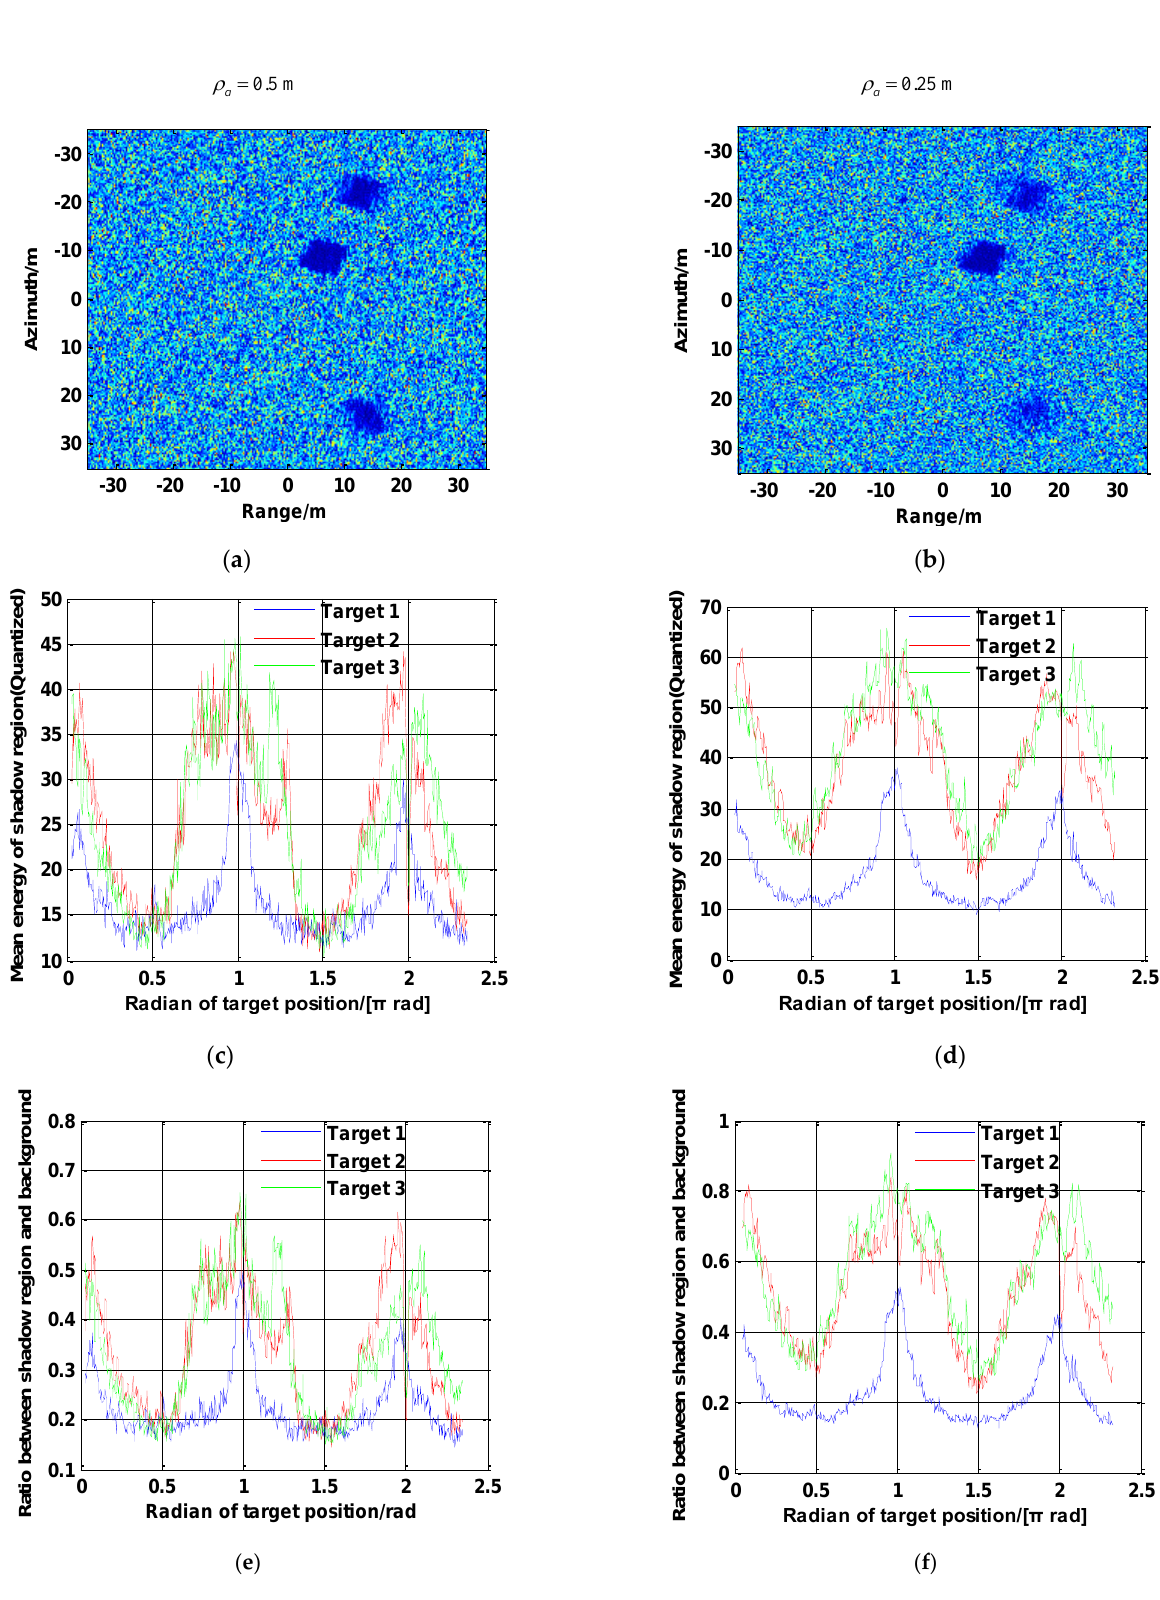
Figure 17. Results of experiment 3. The meanings of ( a–f ) are the same as those of ( a–f ) in Figure 15.